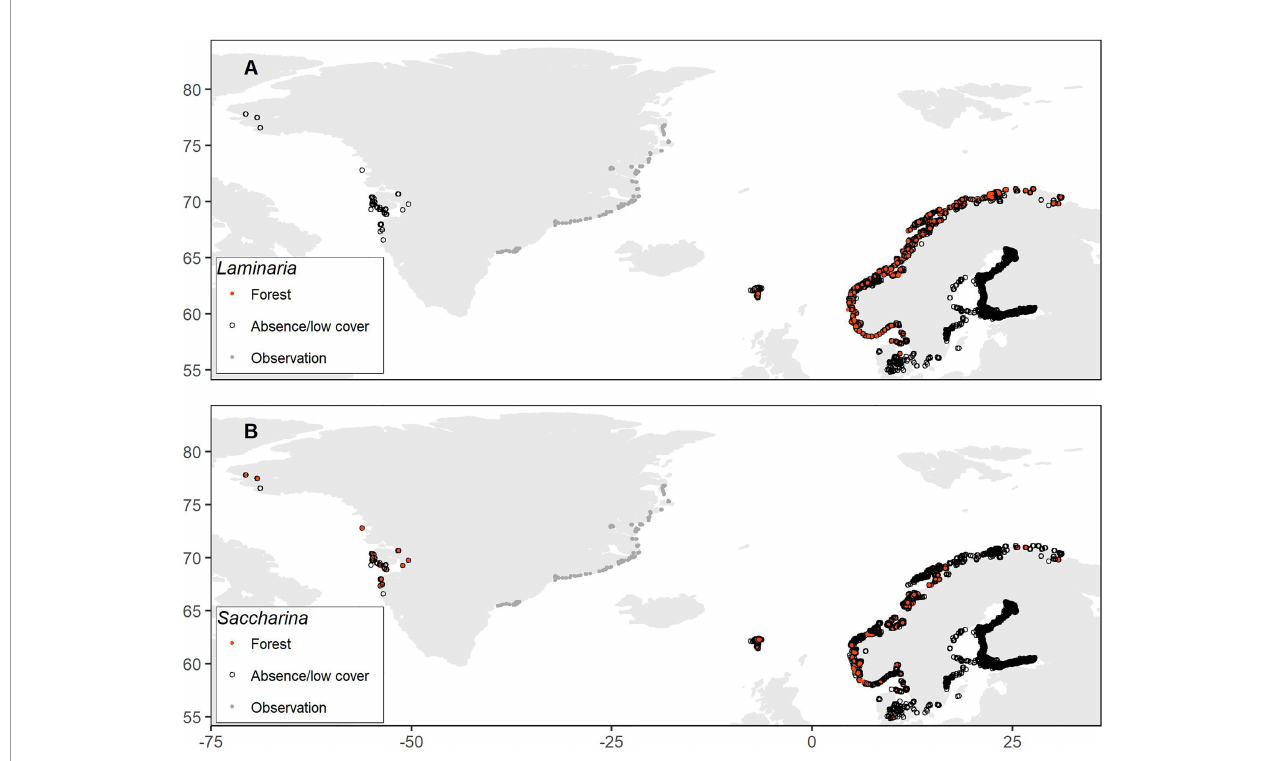
FIGURE 1 | Observed presence or absence of kelp forests (dense or moderately dense forest) of the genera Laminaria (A) and Saccharina (B) across the Nordic region, obtained from quantitative or semi-quantitative data on coverages or densities. For the east coast of Greenland, only the locations of observations are depicted (the original data are